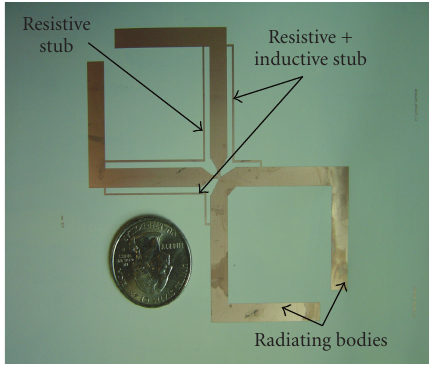
Figure 6: Dual antenna